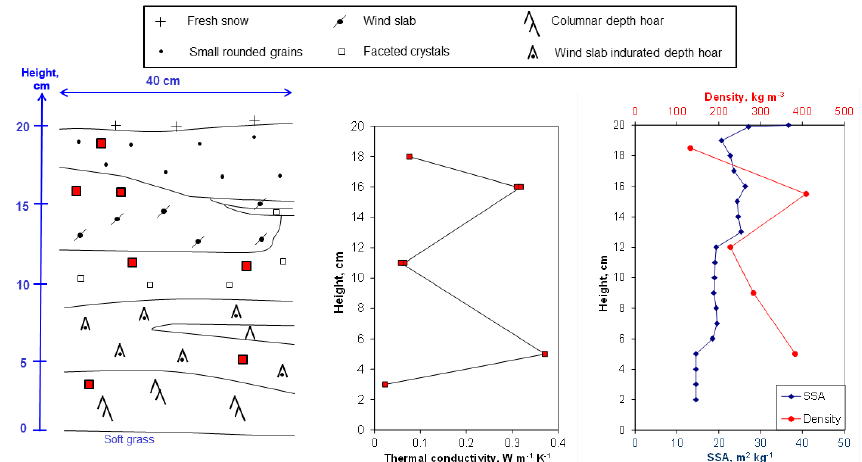
Figure 7. Stratigraphy and vertical profiles of snow physical properties near our study site on 14 May 2014. Fresh snow is just a 2mm thick sprinkling, also visible in the SSA profile. Density data are for the middle of the 3cm high sample. Snow type symbols are those of Fierz et al. (2009), except for the lower wind slab, which transformed into depth hoar to form an indurated layer, as detailed in the text. Red-filled black squares in the stratigraphy indicate where thermal conductivity measurements were made.